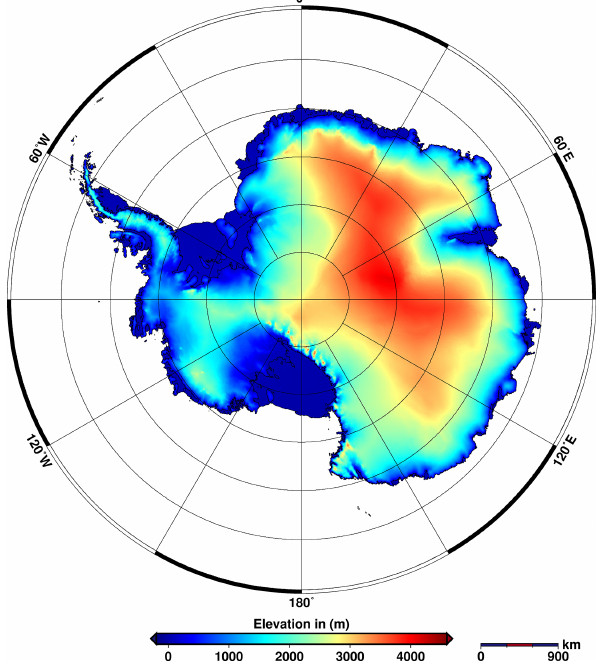
Figure 6. Surface slopes, estimated from the new elevation model of